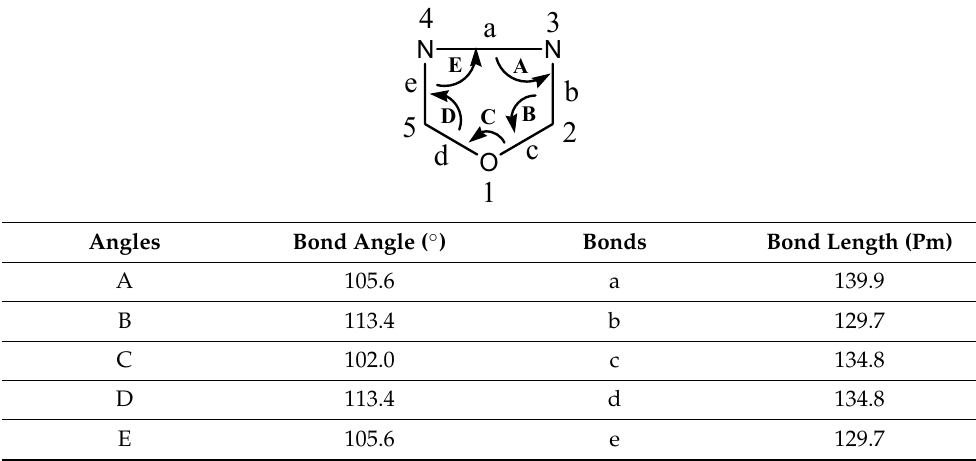
Figure 2. Chemical structures of oxadiazole isomers.